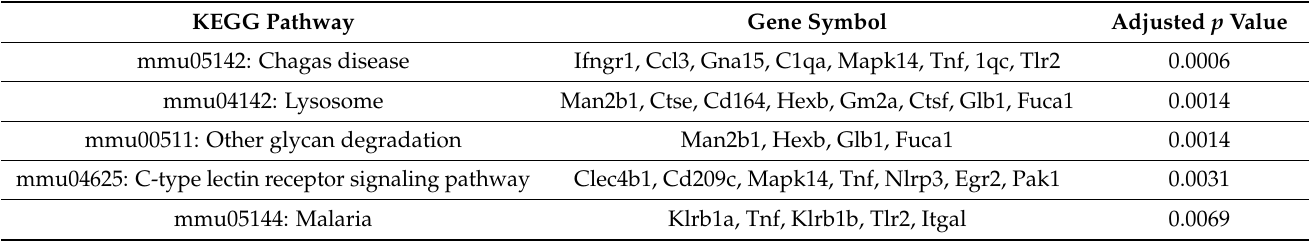
Table 3. KEGG pathways enriched by downregulated DEGs in L . infantum -infected BM-DCs. KEGG